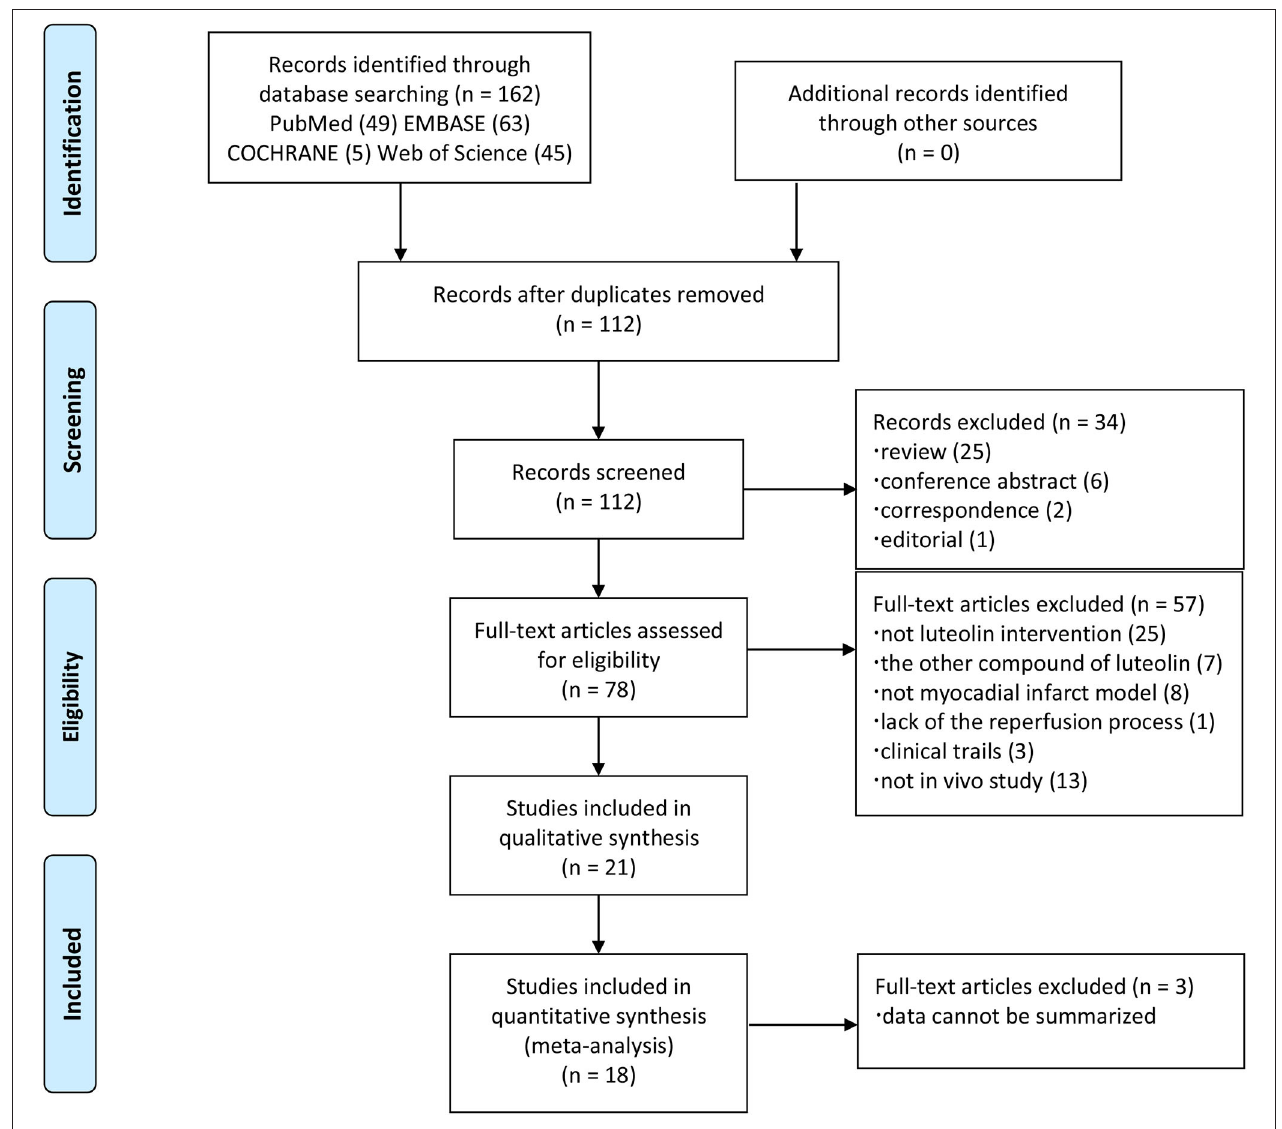
FIGURE 1 | PRISMA flow chart of the search